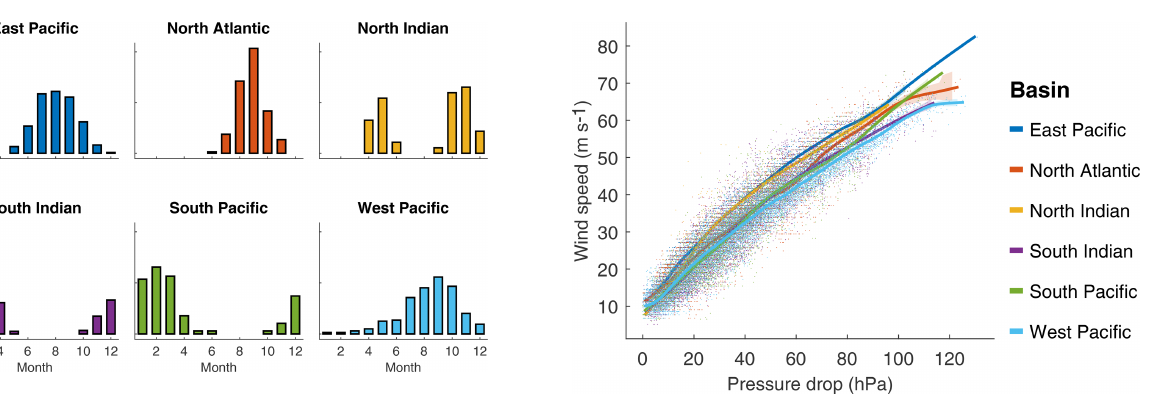
Figure 5. Relative monthly distribution (%) of cyclones in each basin defined by potentially damaging cyclones (over 35ms − 1 ) in IBTrACS. Each bar gives the probability of each cyclone being al- located to a given month.